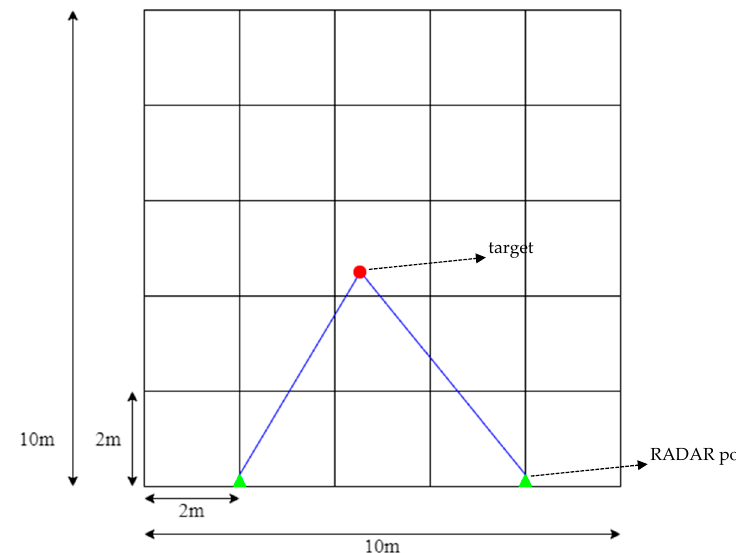
Figure 5. Sector Find though DNN.